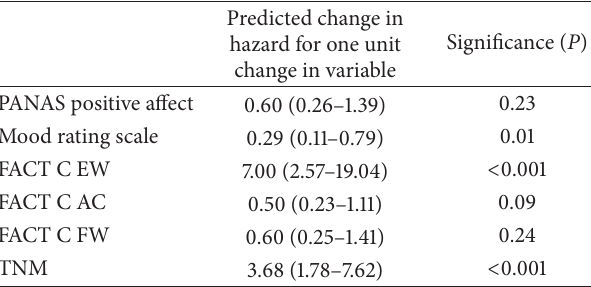
Table 4: Multivariate analysis of preoperative Qol and survival with TNM stage as covariate.